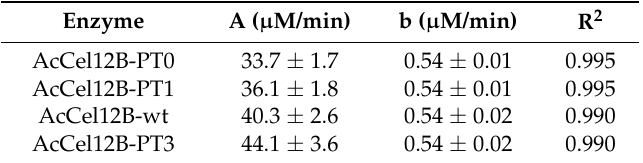
Table 3. The rate distribution of reducing ends in time course of RAC hydrolysis.